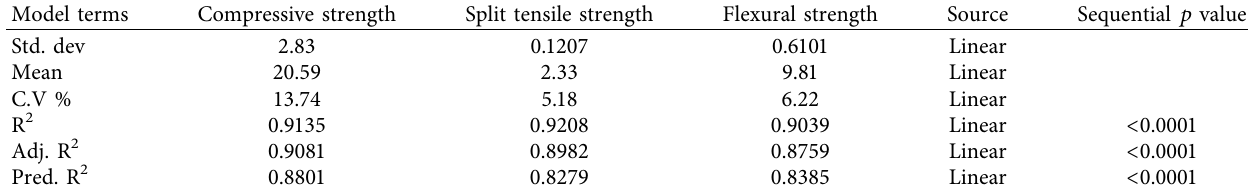
Table 6: Models’ validation.